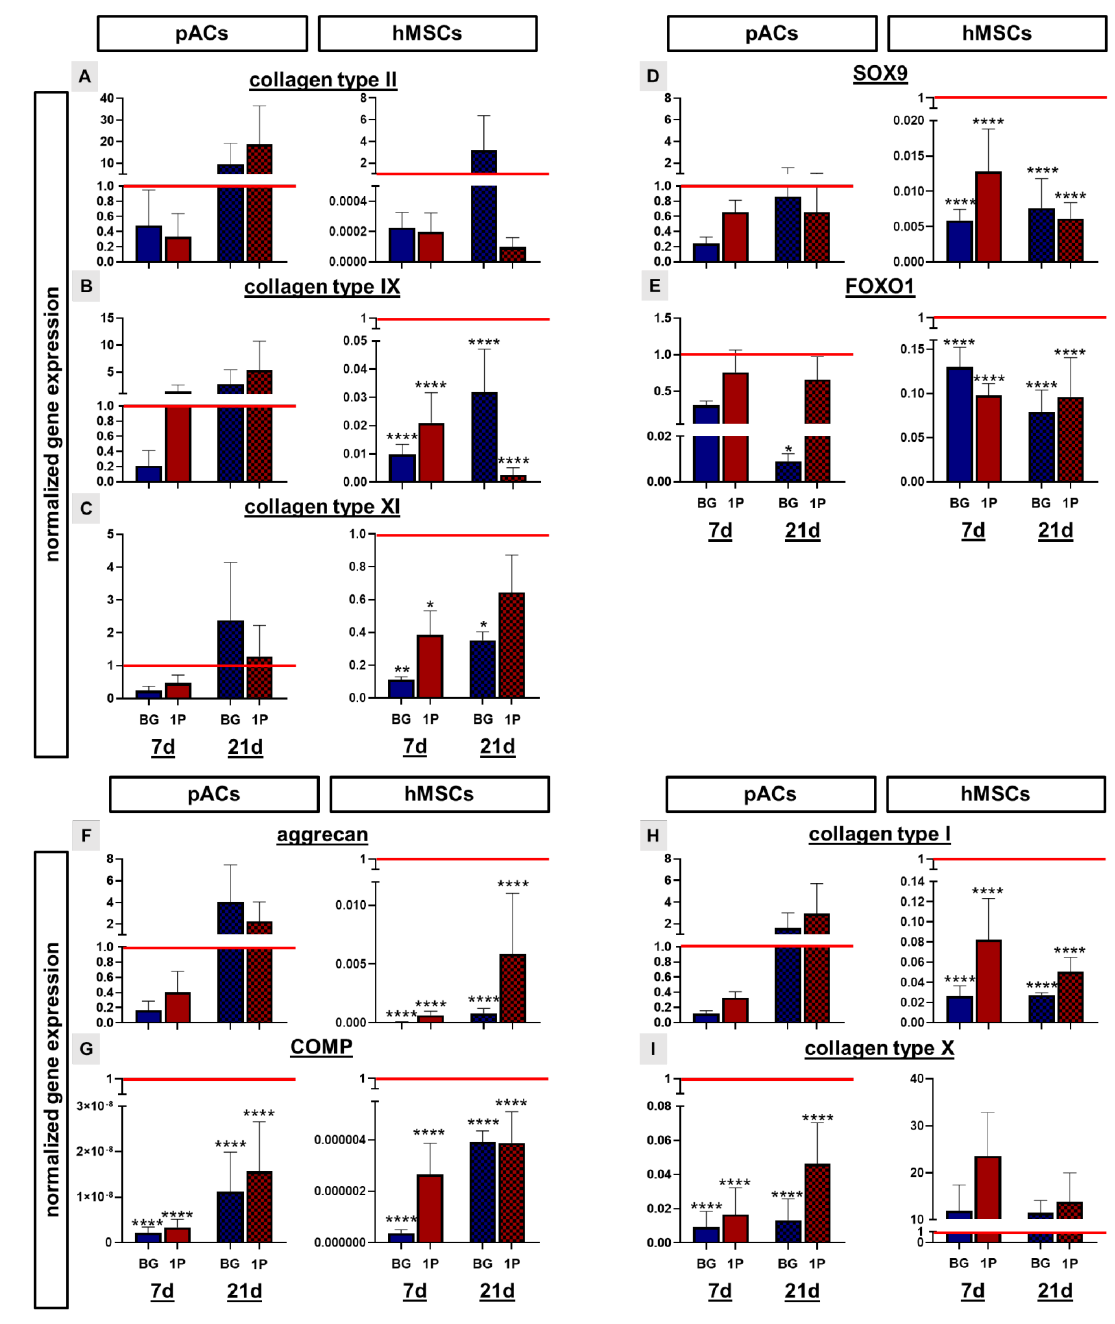
Figure 10. Normalized gene expression of cartilage extracellular matrix components and the tran- scription factors SOX9 and FOXO1 after 7 (full bars) and 21 (checkered bars) days (d) in the BG scaffolds (blue) and the PLGA-infiltrated BG scaffolds (red). Relative gene expression of collagen types II ( A ), IX ( B ), XI ( C ), SOX9 ( D ), FOXO1 ( E ), aggrecan ( F ), COMP ( G ), collagen types I ( H ) and X ( I ) were related to the native porcine cartilage (red line = 1). The pure bioactive glass (BG, blue) and single (1P, red) PLGA infiltration. Three independent experiments with cells of three different donors are summarized and show mean with standard deviation. Significant differences were calculated after one-way ANOVA (post hoc Tukey Test): p values * p < 0.05, ** p < 0.01, **** p < 0.0001. Gene expression was normalized to the reference gene β -actin (ACTB). pACs: porcine articular chondrocytes, hMSCs: human mesenchymal stem